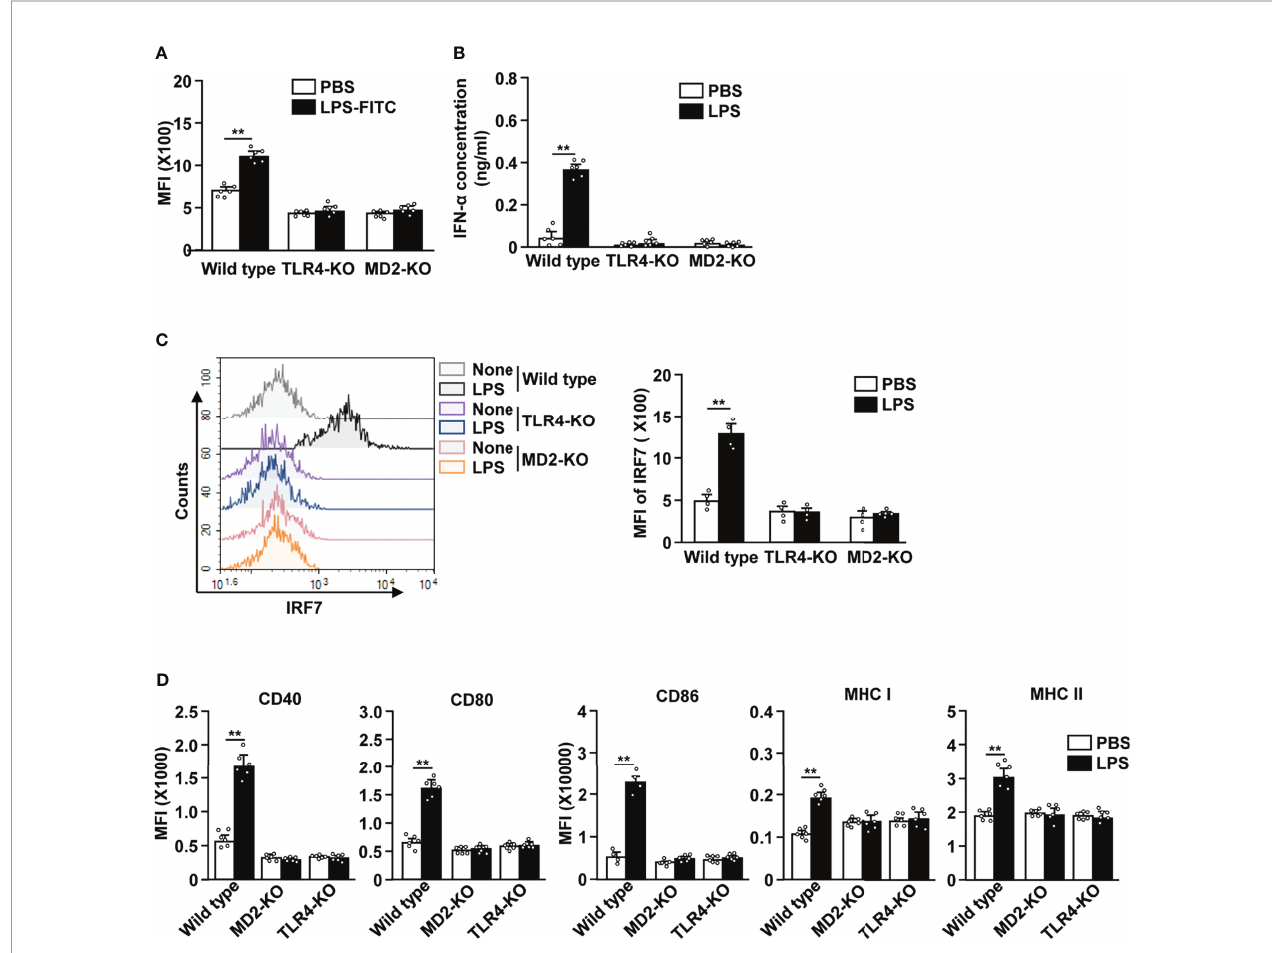
FIGURE 5 | LPS-induced pDC activation requires TLR4 and myeloid differentiation factor 2 (MD2). (A) LPS binding in pDCs was measured in C57BL/6 (wild type), TLR4-knockout (KO), and MD2-KO mice by fl ow cytometry (n = 6 mice, two-way ANOVA, mean±SEM, **p < 0.01 ). (B to D) Wild type, TLR4-KO, and MD2-KO mice were injected i.p. with PBS and 0.1 mg/kg LPS. Twelve hours after LPS injection, spleen and serum were harvested. (B) Serum concentration of IFN- a was measured by ELISA (n = 6 mice, two-way ANOVA, mean±SEM, **p < 0.01 ). (C) Expression levels of IRF7 in pDCs were analyzed by fl ow cytometry (left panel). MFI of IRF7 expression levels were shown (right panel, n = 4 mice, two-way ANOVA, mean±SEM, **p < 0.01 ). (D) MFI of costimulatory molecules, and class I and II MHC were shown (n = 6 mice, two-way ANOVA, mean±SEM, **p < 0.01